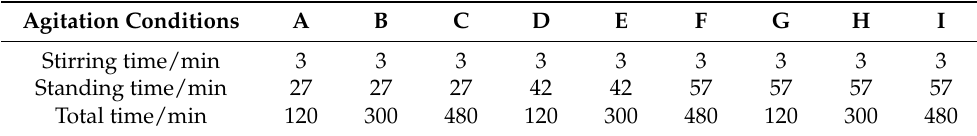
Table 1. Agitation conditions at the cell attachment